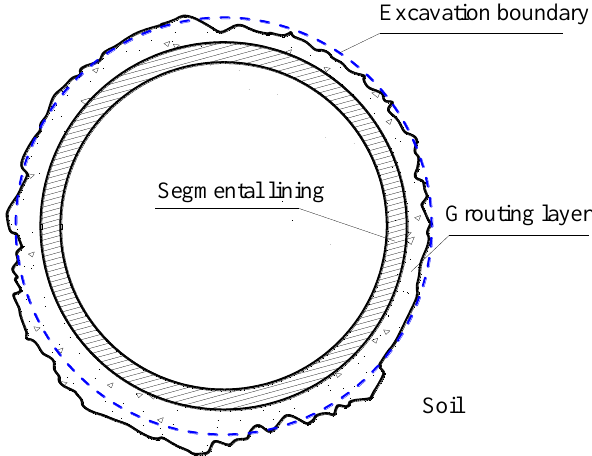
Figure 1. Schematic diagram of backfill-grouting-layer distribution.